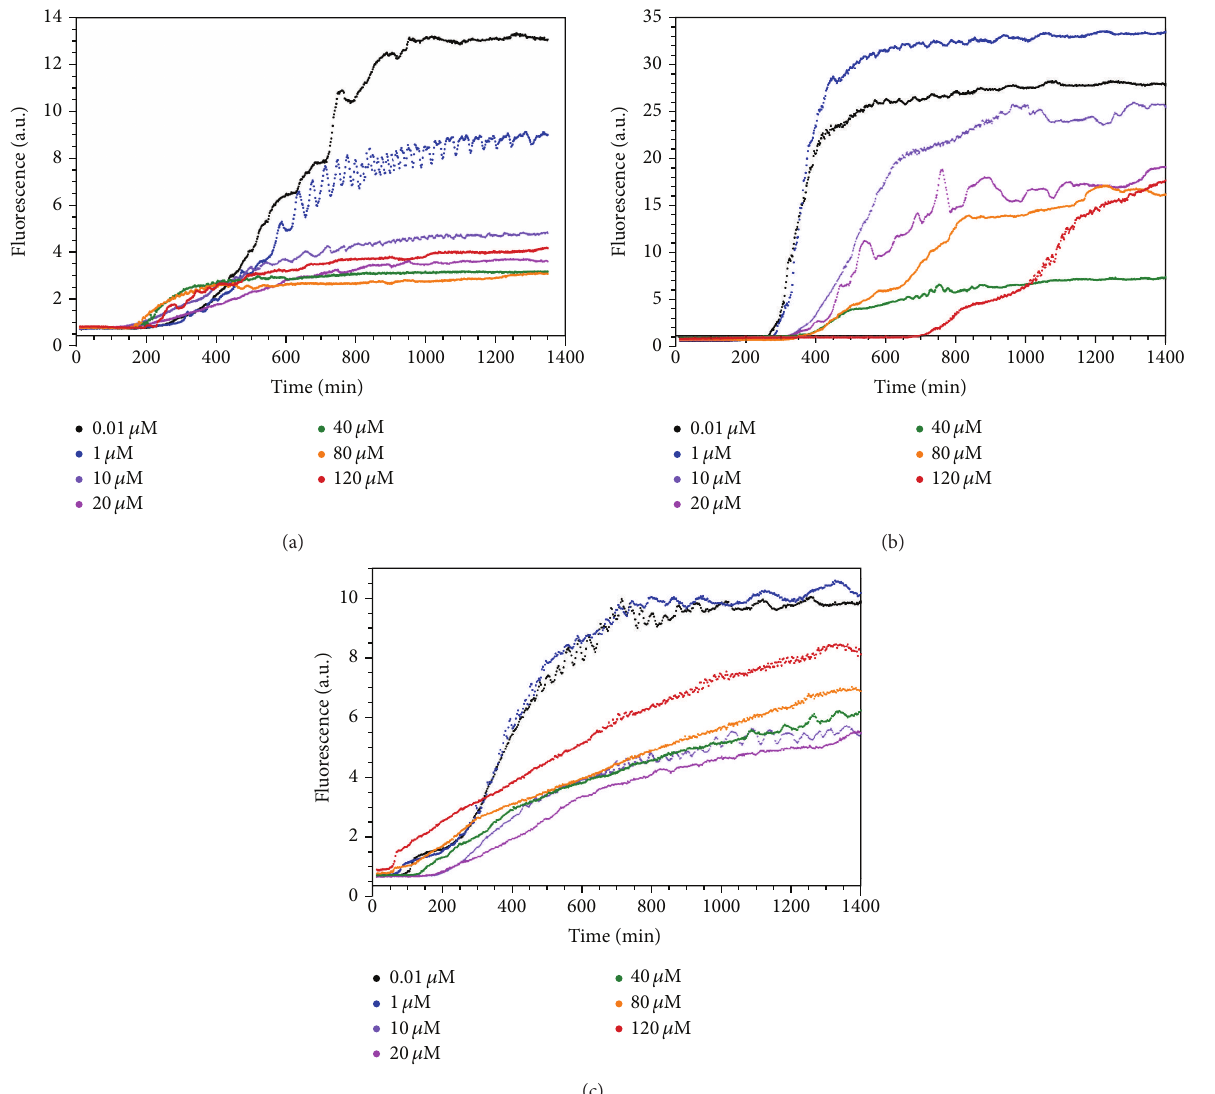
Figure 4: Representative reaction profiles showing the effects of peptide inhibitors at the indicated concentrations on the fibrillization of 20 𝜇 M WT-amylin: (a) Arg-1, (b) Arg-2, and (c) Mem-T. All reactions were done in the presence of 150 mM NaCl. A single-step fibril-formation process was assumed for the analysis of all the kinetic reactions. Although some of the reactions appear to show more complicated fluctuations in the data, these are likely experimental noise (the presence of particulate fibrils leads to nonideality in fluorescence measurements) as they are not observed in replicate